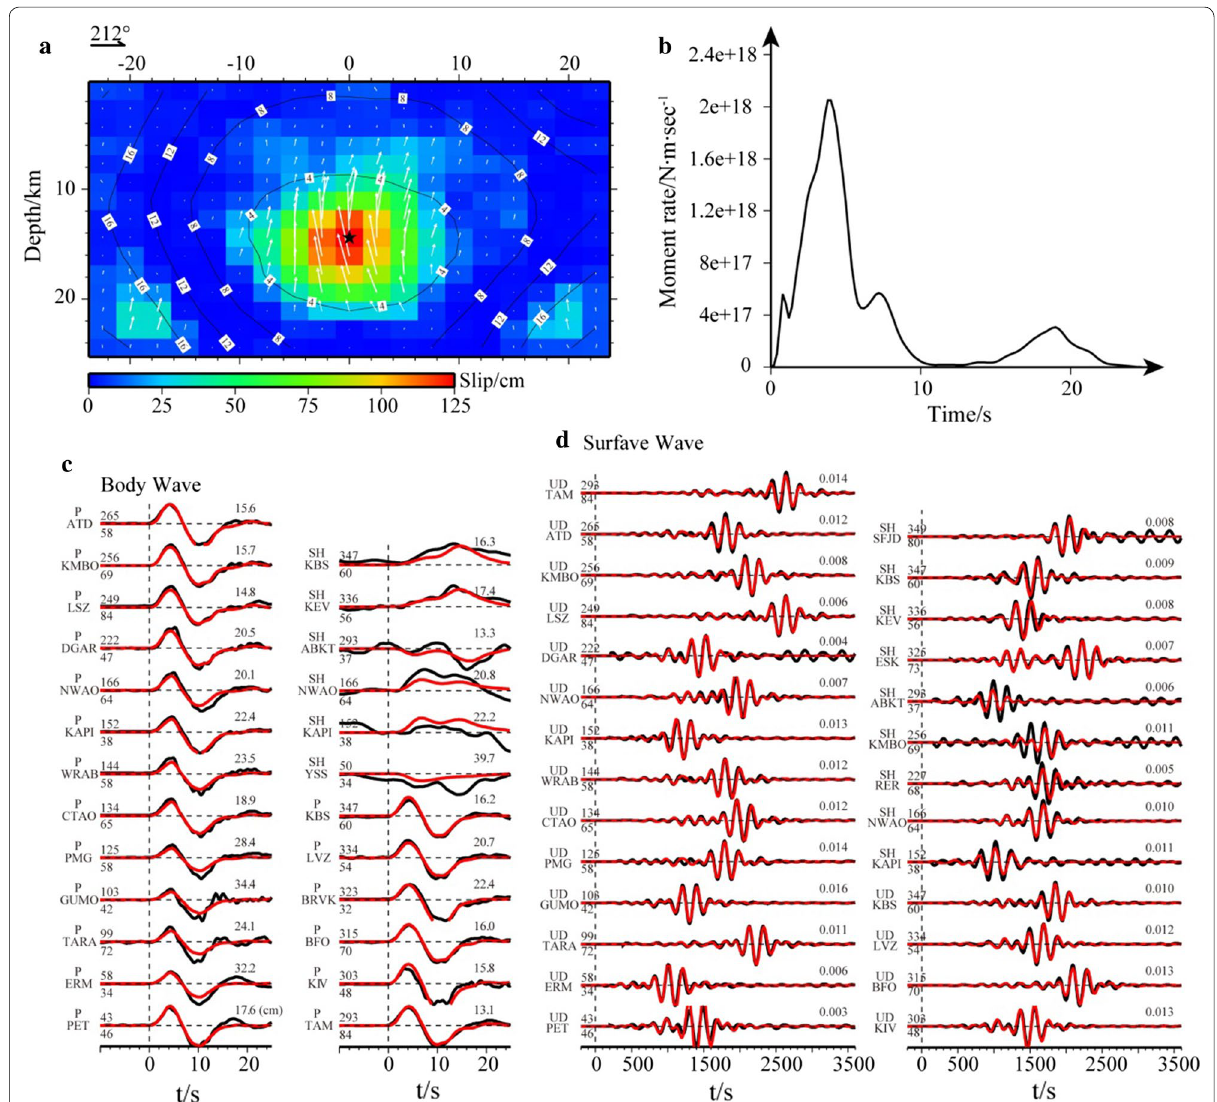
Fig. 3 Inversion results of the 2013 Lushan earthquake. a Slip distribution on the fault plane, the star represents the epicenter, the size and direction of the arrows represent the slip size and slip direction, the number is the rupture propagation time. b Scalar seismic moment rate evolution versus time. c Match of observed teleseismic body waves and synthetic waveforms. d Match of observed teleseismic surface waves and synthetic waveforms, the black line and red line indicate the observed record and synthetic seismogram, the station, azimuth, epicentral distance and the maximum in observation (in cm) are also